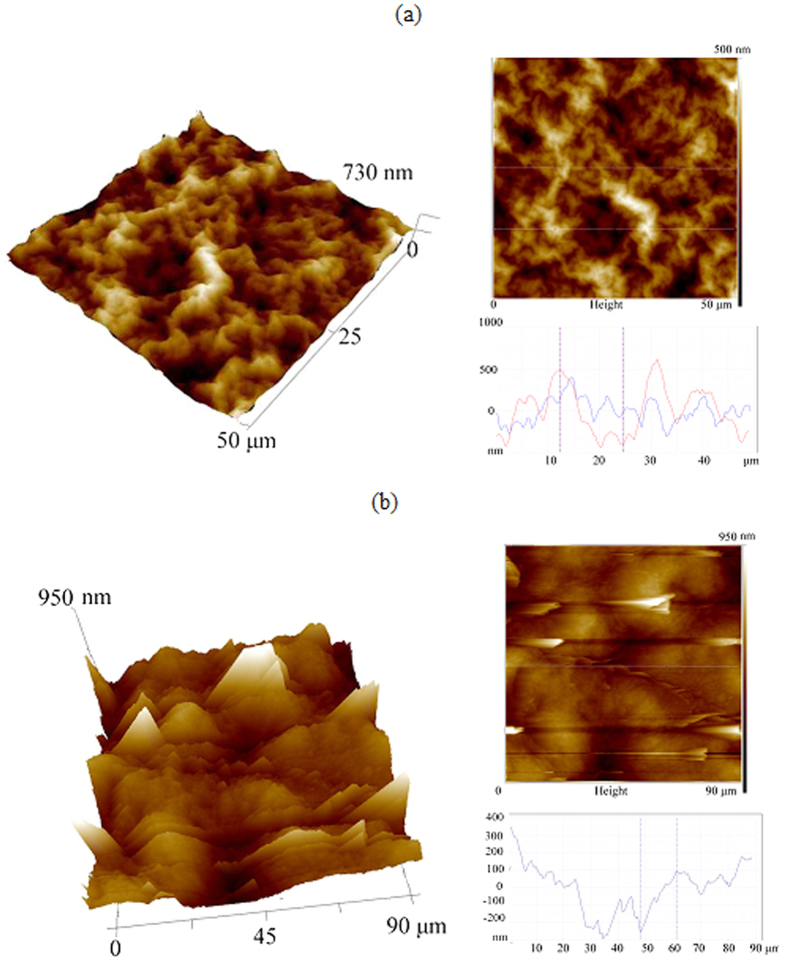
AFM 2D/3D analyses.(a) surface topography of rGO in N2 gas (b) surface topography of rGO in liquid N2.